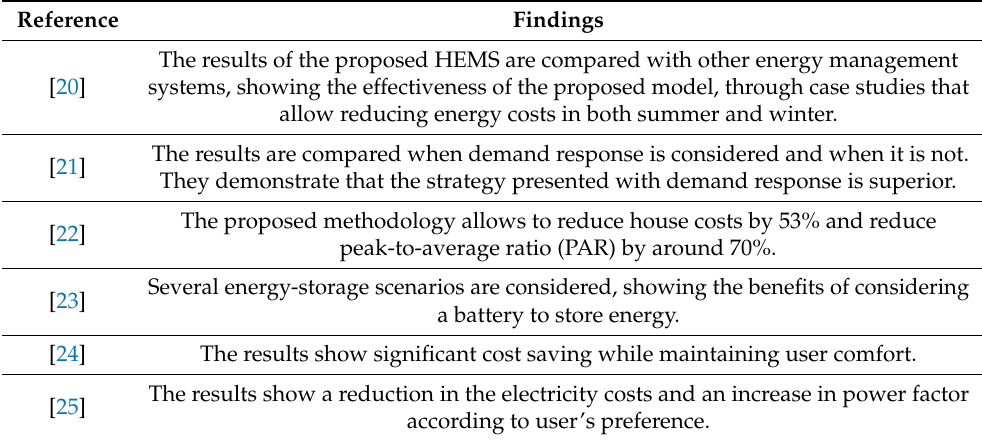
Table 7. Findings of selected papers associated with mixed-integer linear